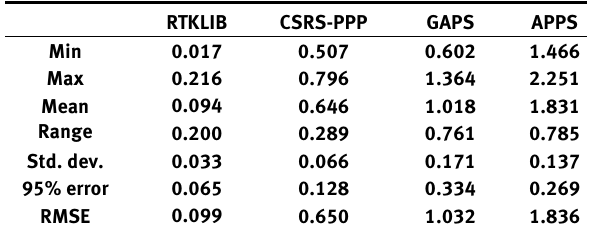
Table 3. Results for 2D displacements (Agisoft) (m).